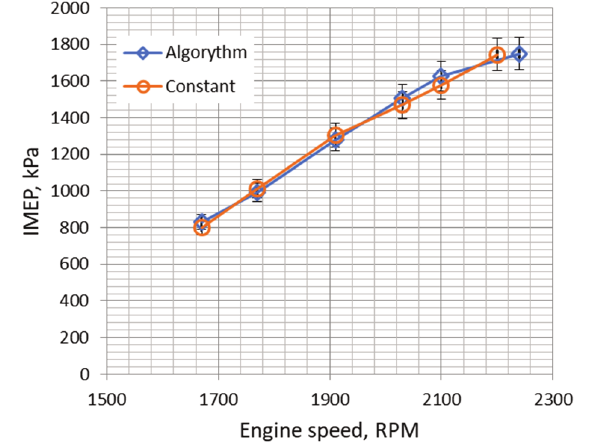
Fig. 8. Differences in standard deviation of IMEP power between engines with constant and variable ignition advance